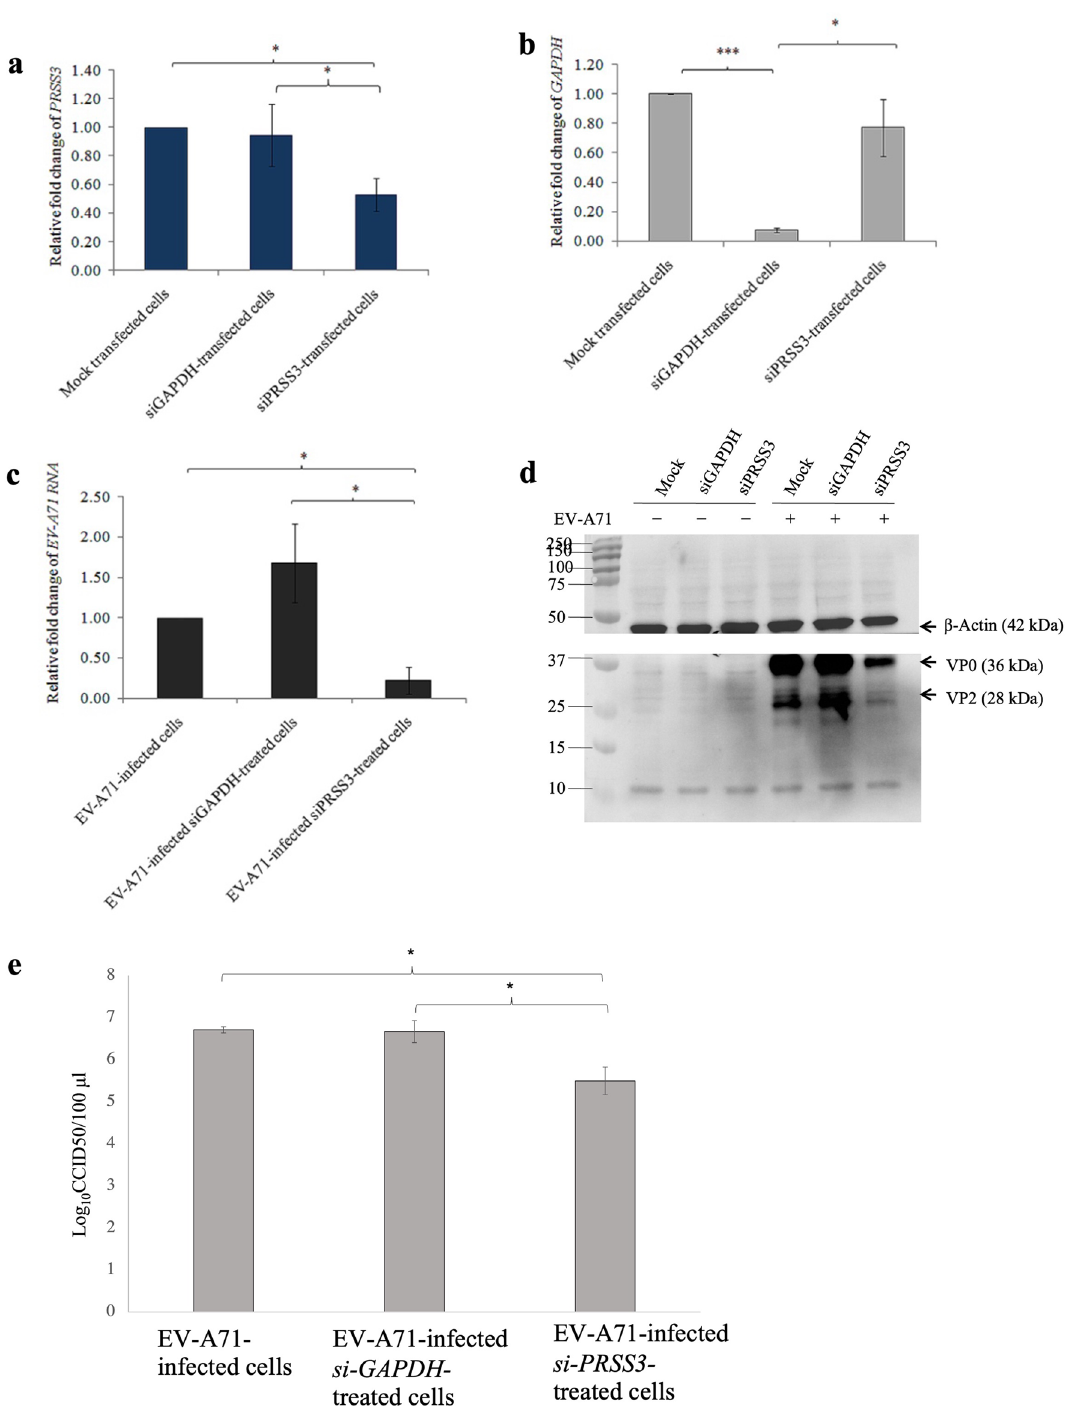
Figure 7. Determination of relative fold-changes of EV-A71 RNA copy numbers by qRT-PCR in response to the knockdown of PRSS3 . ( a ) Fold-changes of gene expression of PRSS3 and ( b ) GAPDH in the siRNAs-transfected non- infected cells were relative to the mock transfected non-infected cells. ( c ) Relative fold-changes of EV-A71 RNA copy numbers in siPRSS3 -transfected HEK293T cells infected with EV-A71 when compared with siGAPDH- transfected- and untransfected infected cells. The qRT-PCR data were expressed by mean ± SD from three independent experiments in triplicate measurements (N = 9). ( d ) Western blot analysis of EV-A71 protein synthesis upon siRNA-mediated gene silencing of PRSS3 when compared with the control groups . The EV-A71 proteins detected by anti-EV-A71 antibody are VP0 (MW = 36 kDa), pre-cleavage product of VP2, and VP2 (MW = 28 kDa). Human β-actin (MW = 42 kDa) was used for normalization of protein loading. ( e ) The titers of virus released from PRSS3 -silenced cells, si - GAPDH transfected- and untransfected cells were determined by CCID50 method. The data was derived from triplicate experiments. Statistical analysis was done by One-way ANOVA with post- hoc tests. Levels of statistically significant difference at p < 0.05 and p < 0.001 were indicated by * and ***, respectively. The original blots of ( d ) were shown in Supplementary Fig.